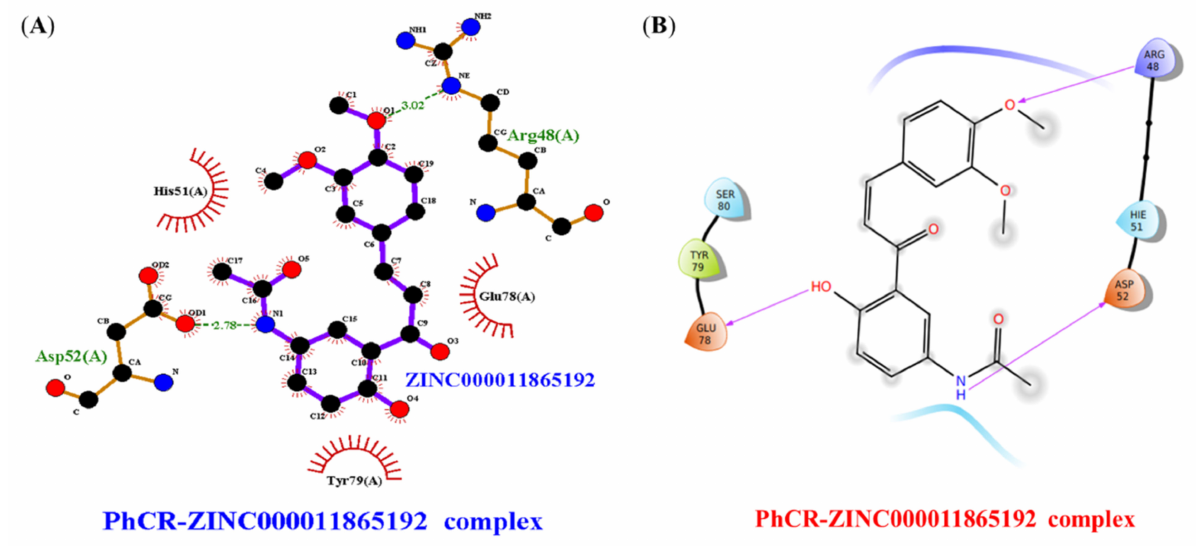
Figure 5. Intermolecular H-bonding, electrostatic, and hydrophobic interactions formed between PhccR–ZINC000011865192 complexes. The image ( A ) is drawn by the LigPlot+ tool and ( B ) ligand interaction module of